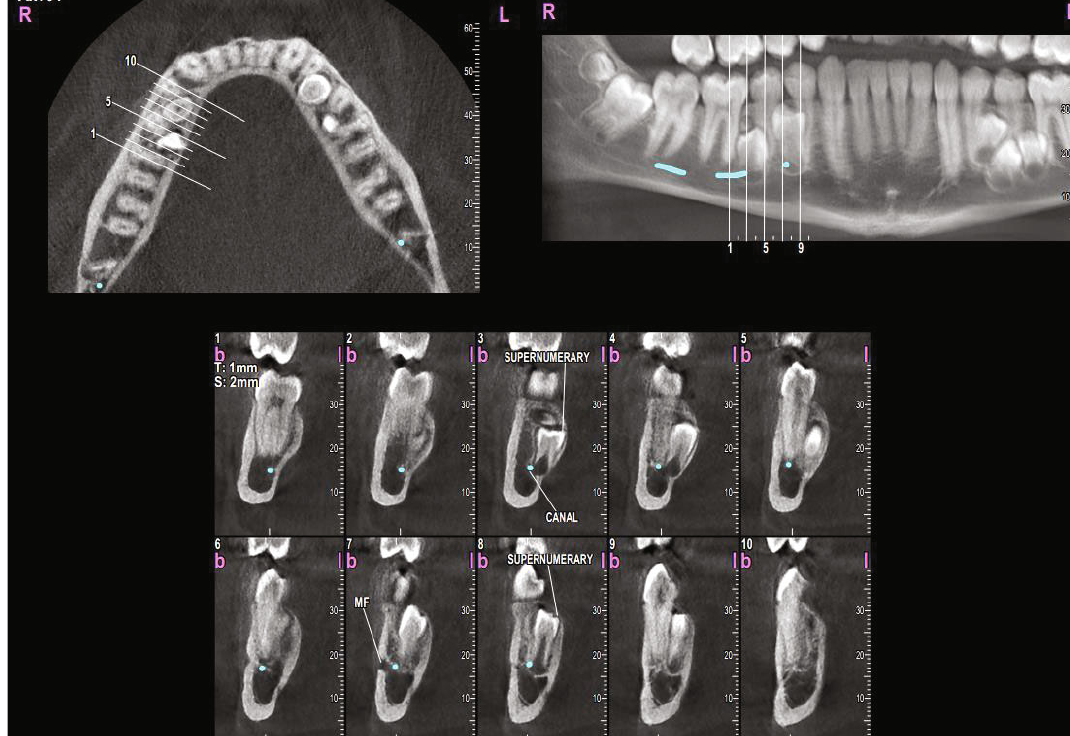
Figure 7: Vertical sections perpendicular to the alveolar ridge, showing the position and morphology of supernumerary teeth in the mandibular right quadrant.